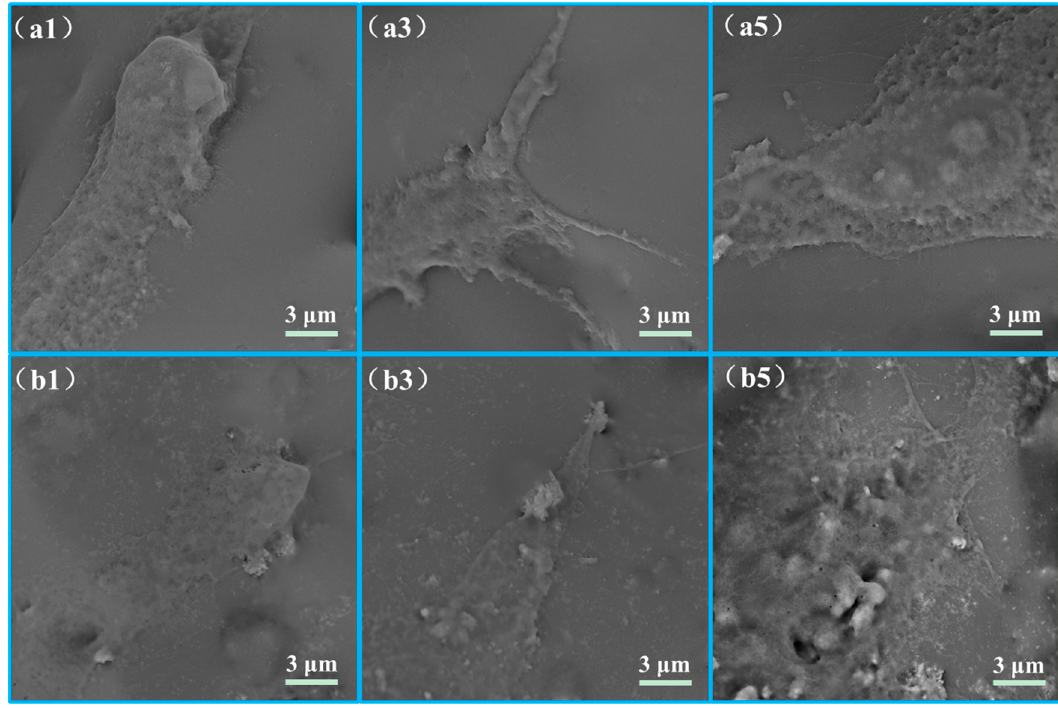
Figure 10. Cells on the ( a1 – a5 ) PEEK/PGA and ( b1 – b5 ) PEEK/PGA-5%nTiO 2 scaffolds after culture for 1, 3, and 5 days.